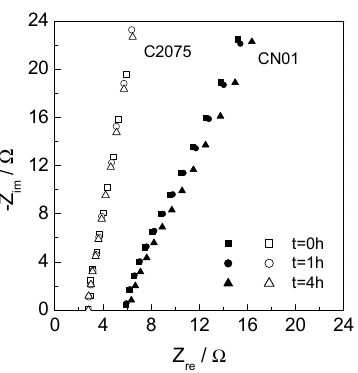
Figure 6. Nyquist plots (range 300–20 kHz) of C2075 and CN01 soaked with LP30 at di ff erent time after assembly.